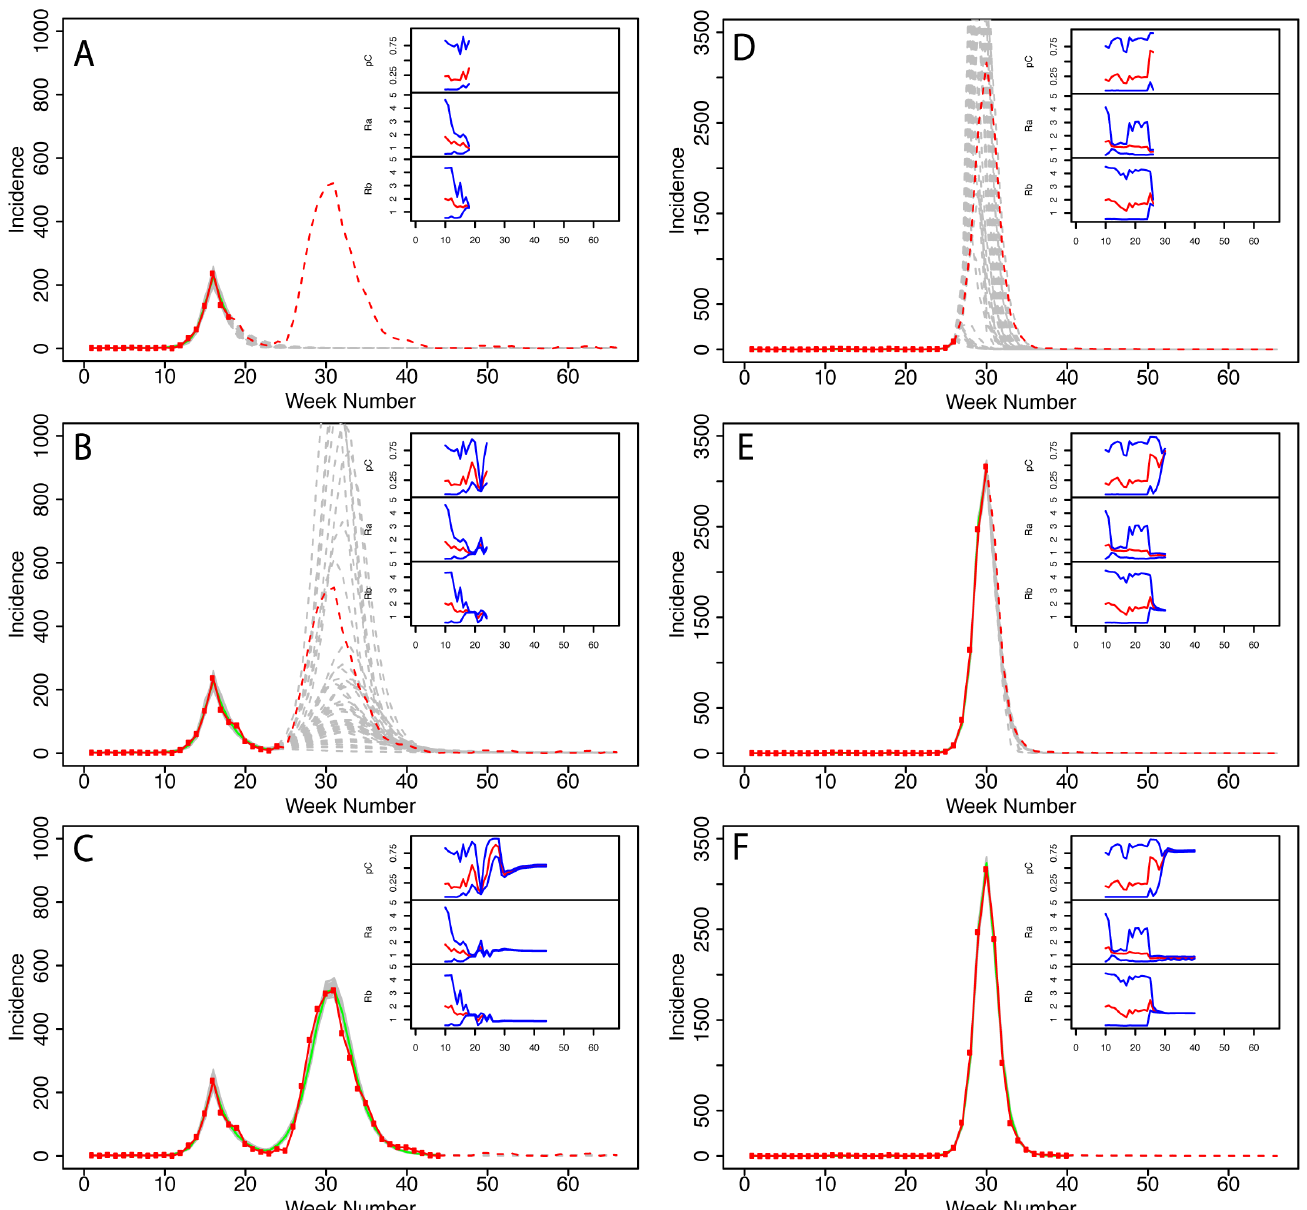
Fig 3. Characterizing a model strain of pandemic influenza in real time for a single population. a-c Three frames illustrating stochastic predictions for an outbreak based on parameters that give a typical two-peak profile (such as that of MPZ-92055), but increasing p C by about an order of magnitude. The grey lines give individual simulation realizations while the green line shows the ensemble average. The data contributing to the realizations is marked in red. The insets show the evolution of computed p C , R A , and R B as more simulated data are added to the predictions. The red line is our median estimate and the blue lines are the 95% confidence intervals. d-f Analogous frames for a typical single-peaked outbreak such as that of MPZ-23708, but again increasing p c by about an order of magnitude.